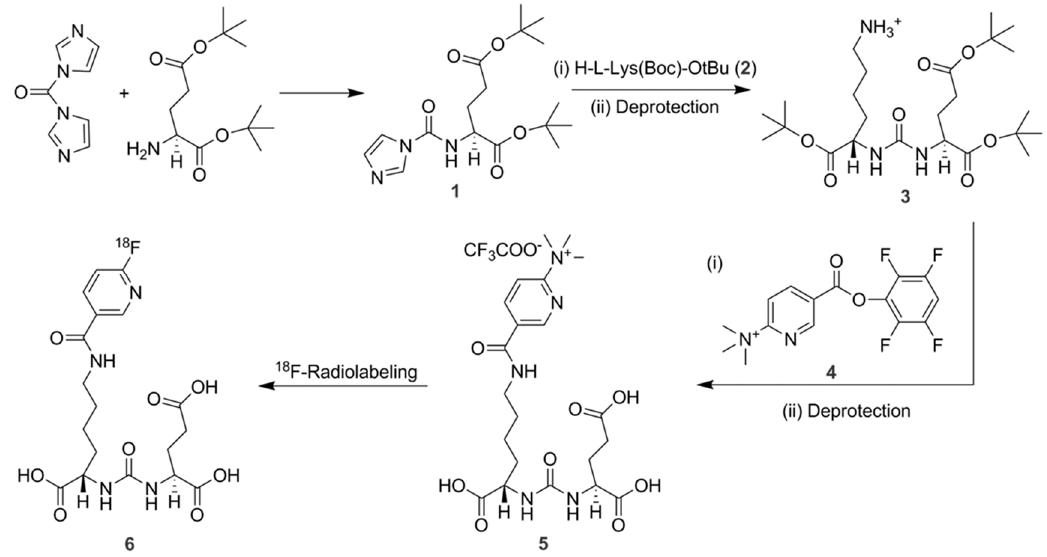
Scheme 1. Synthesis scheme for prostate specific membrane antigen-ligand (PSMAL, 5 ) and 18 F-radiolabeled PSMAL ( 6 ).